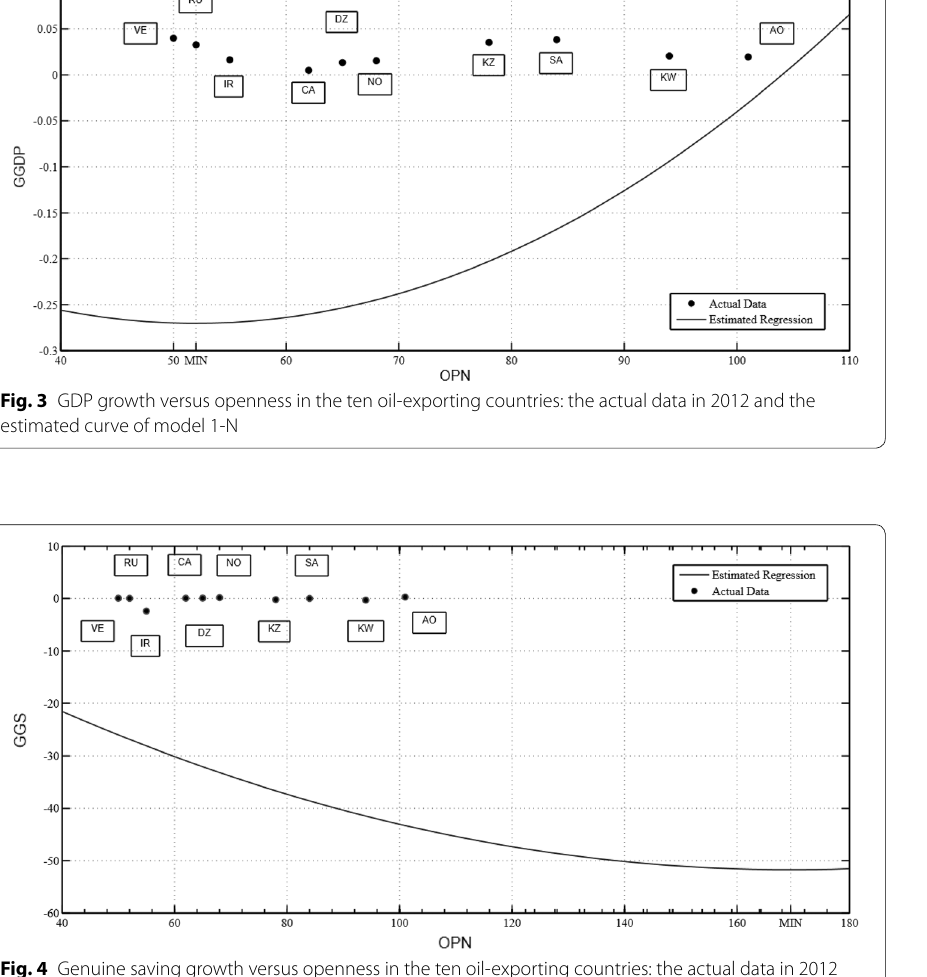
Fig. 4 Genuine saving growth versus openness in the ten oil-exporting countries: the actual data in 2012 and the estimated curve of model